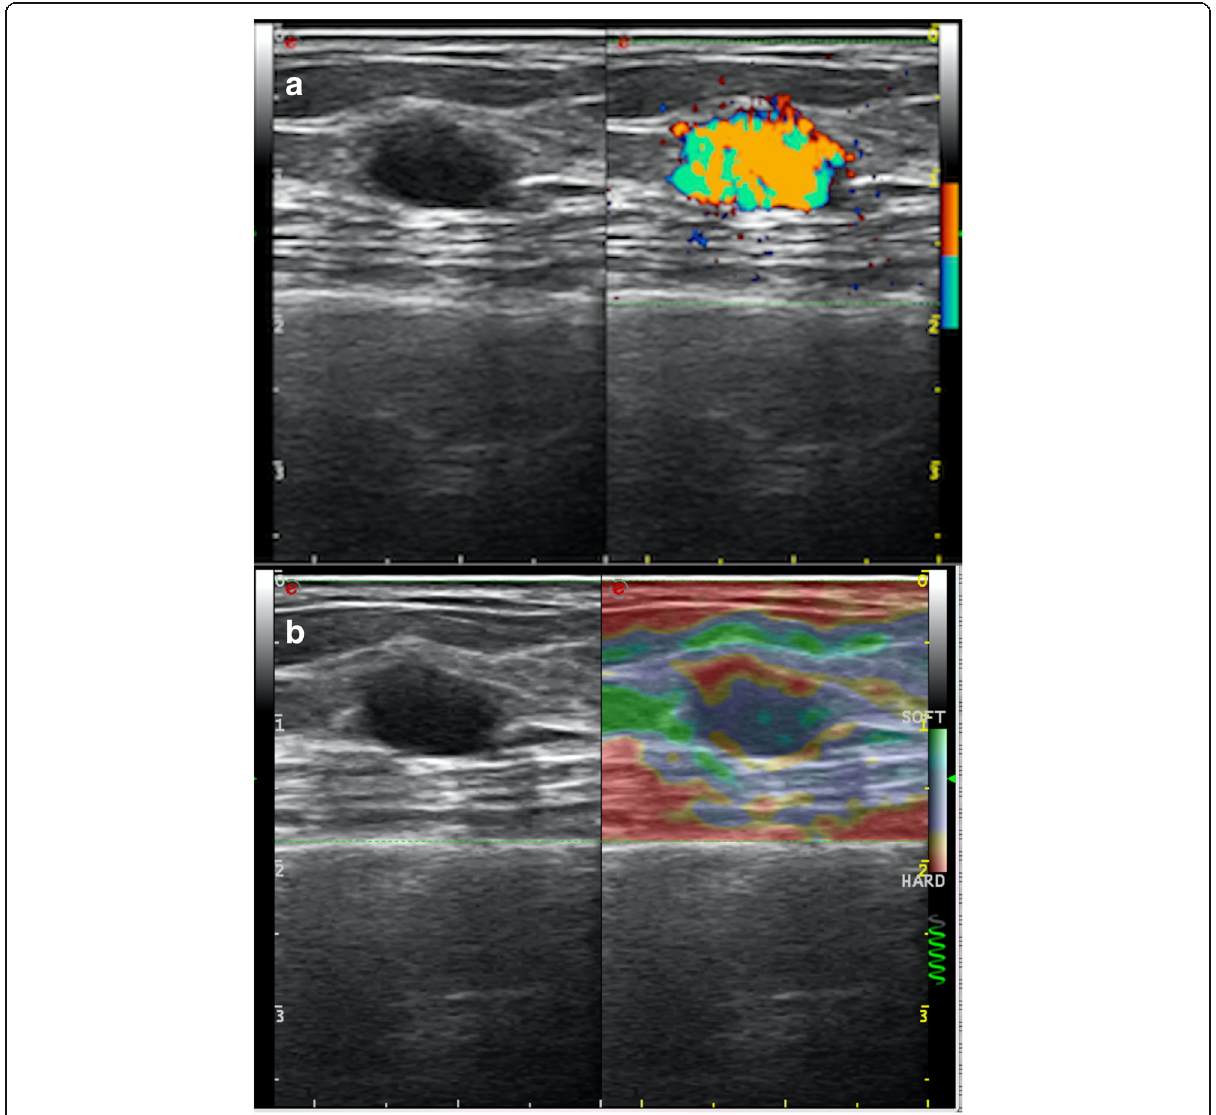
Fig. 1 Breast ultrasonography. Ultrasound of the breast showed an oval, hypo-echoic nodule with well-defined margins and no shadowing. Extensive vascularity was also noted. The RI was 0.62 – 0.67 ( a ). Elastography revealed an E2 lesion ( b